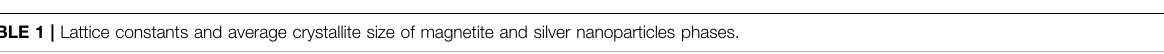
TABLE 1 | Lattice constants and average crystallite size of magnetite and silver nanoparticles phases.